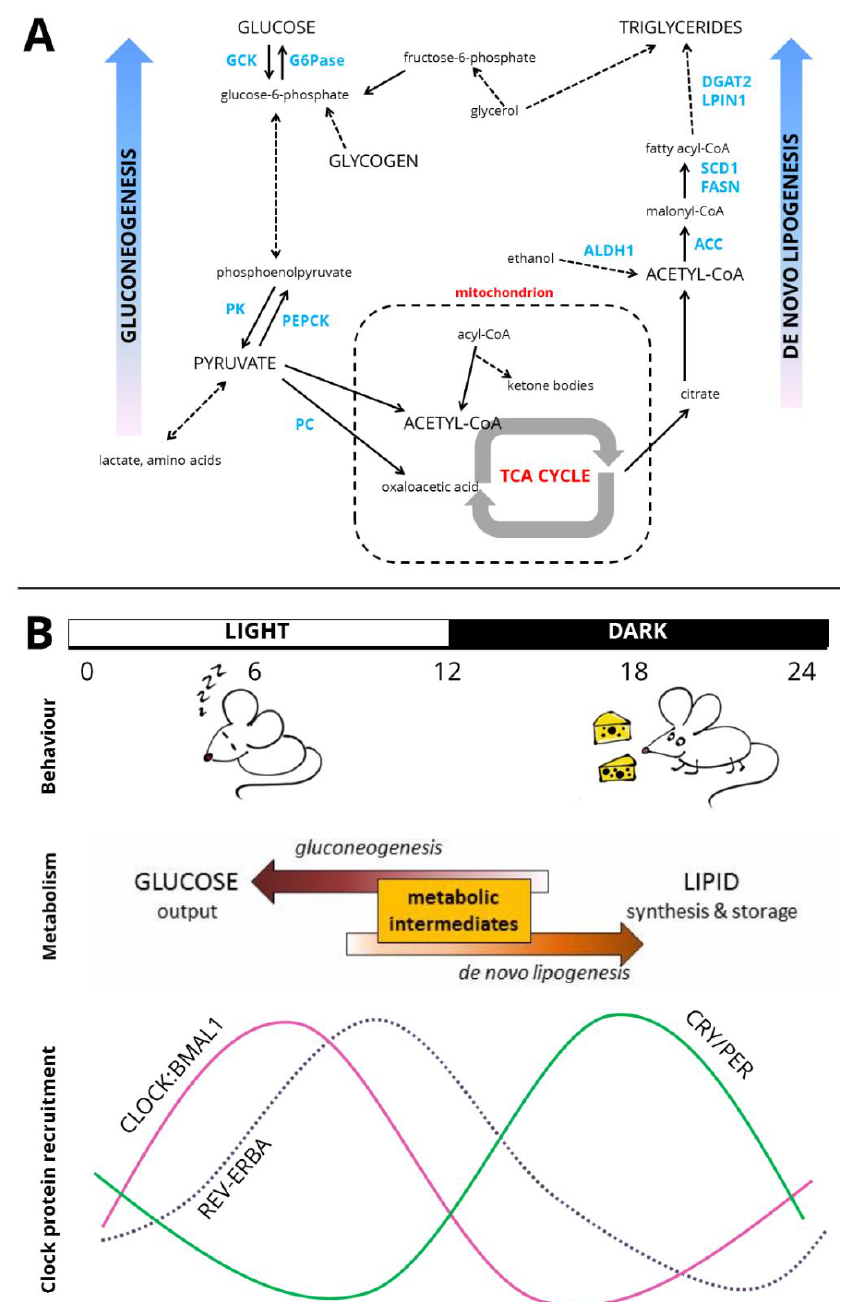
Figure 2. Circadian liver metabolism. ( A ) Pathways of hepatic carbohydrate and lipid metabolism. Key enzymes highlighted in blue. Truncated pathways are denoted by dashed arrows. GCK —